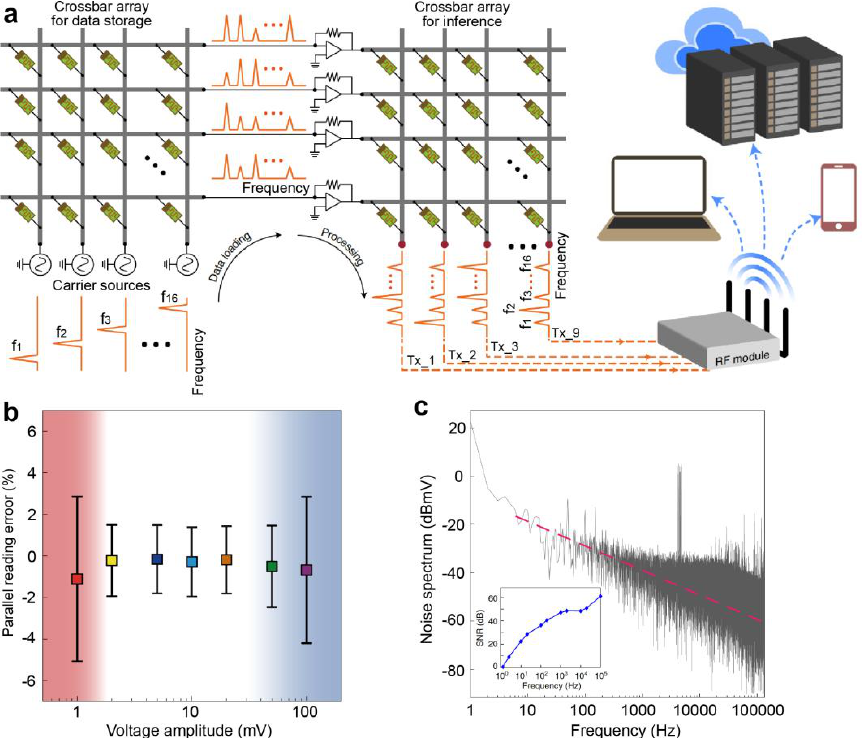
Figure 7. Memristor arrays for frequency multiplexing computing technology. ( a ) Frequency multi- plexing computing technology based on two memristor crossbar arrays for numerous data storage and inference. ( b ) Relative error of the carrier signal for different voltage amplitudes. ( c ) The noise suppression with increasing operating frequency. Reproduced with permission. [76] Copyright 2021, Springer Nature.